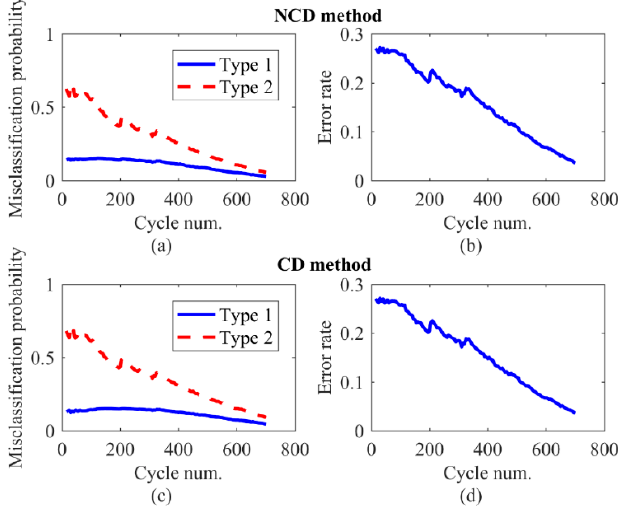
Figure 12. Error rate versus cycle number.